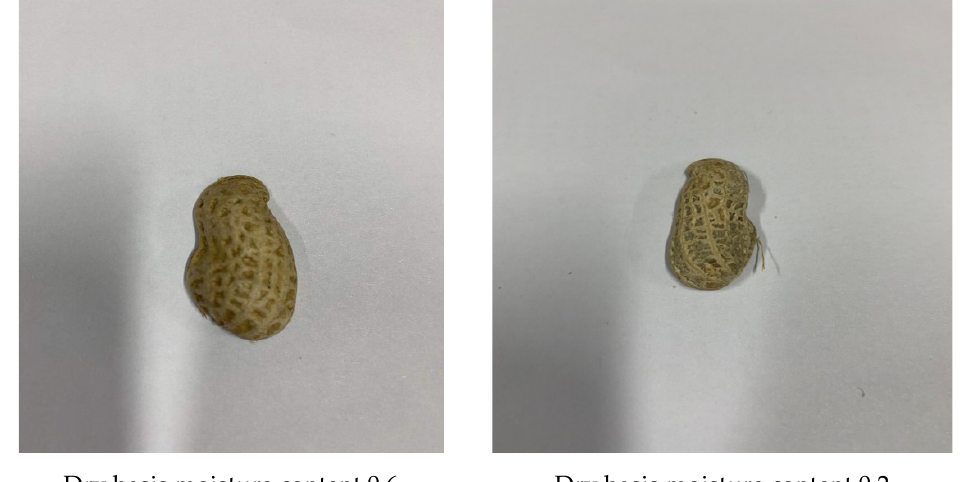
Figure 5. Peanut shells with different dry basis moisture content after IR-SBD treatment.